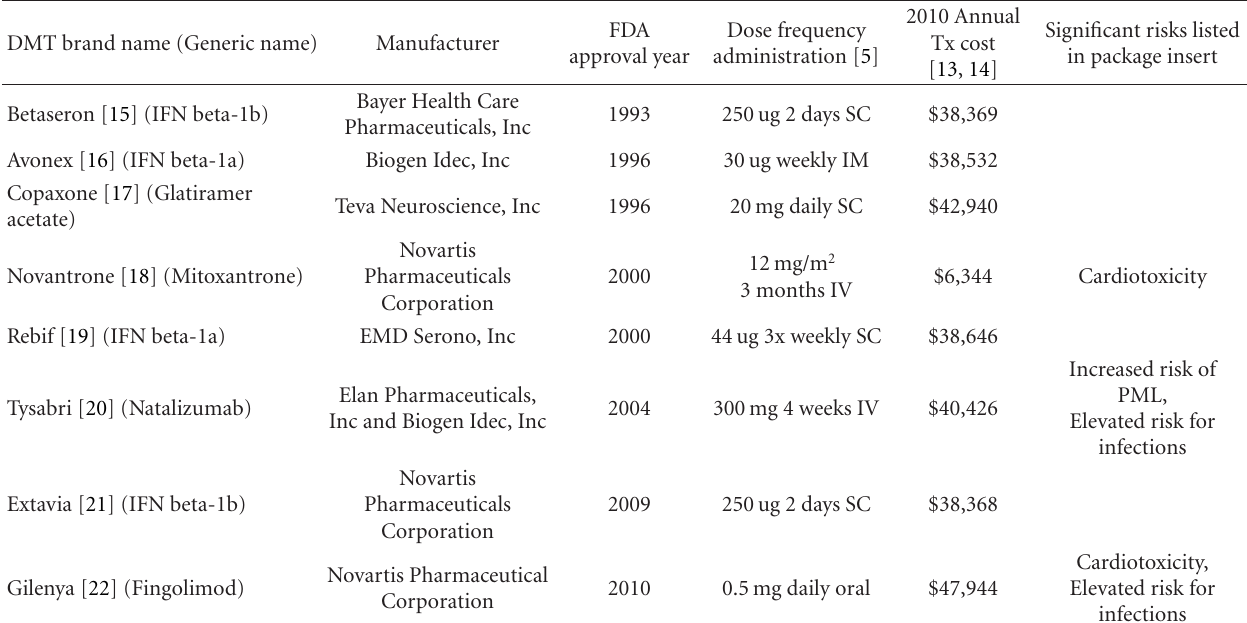
Table 1: Characteristics of disease-modifying therapies for multiple